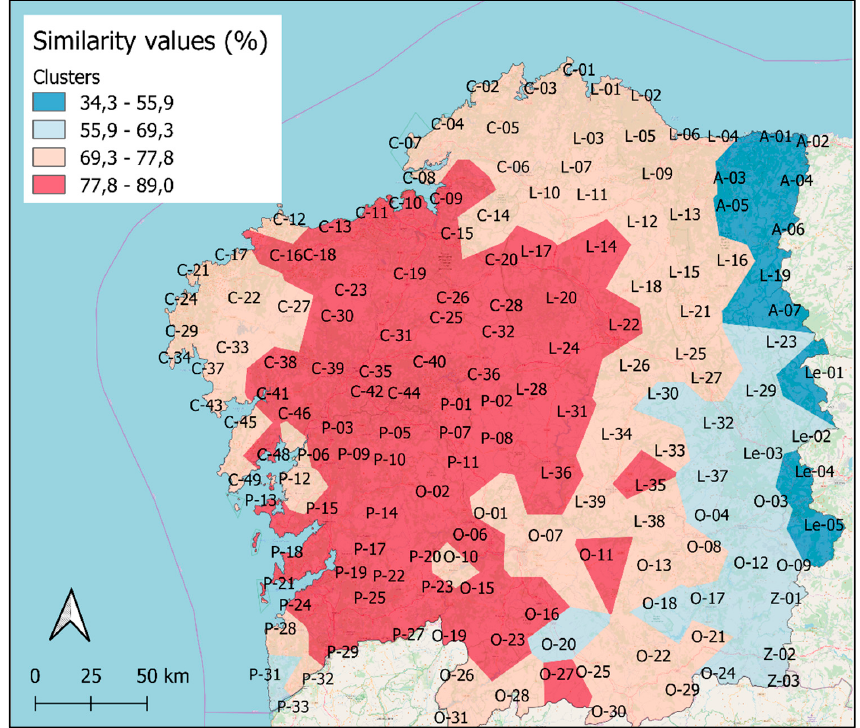
Figure 4. Similarity map: spatial distribution of the similarity values refering to standard variety. In dark red, points showing the highest similarity values (between 77.8% and 89.02%) are highlighted. They occupy an region that lies at the border of the western and central dialectal areas, extending further into the latter, especially in the provinces of A Coruña and Pontevedra. Among these points is the locality of A Lama (P ‐ 17), which has the highest similarity index (89.02%). The distribution in the territory of this red area can be interpreted as signalling that solutions adopted in the standard variety sometimes coincide with the western dialects and sometimes with the central dialects.